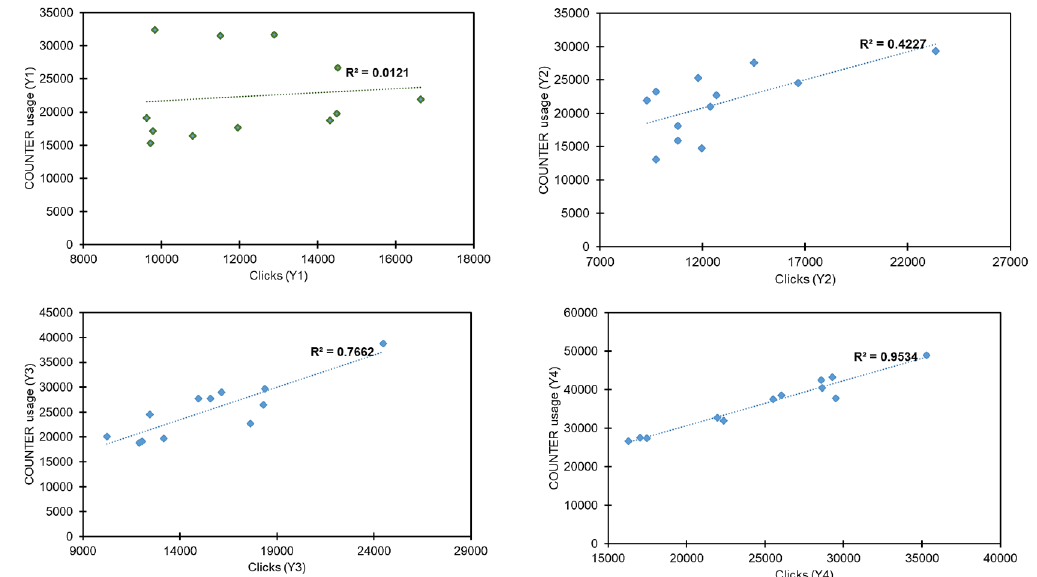
Figure 6. Coefficient of determination (r squared) for Y1, Y2, Y3 and Y4 between clicks and COUNTER usage.